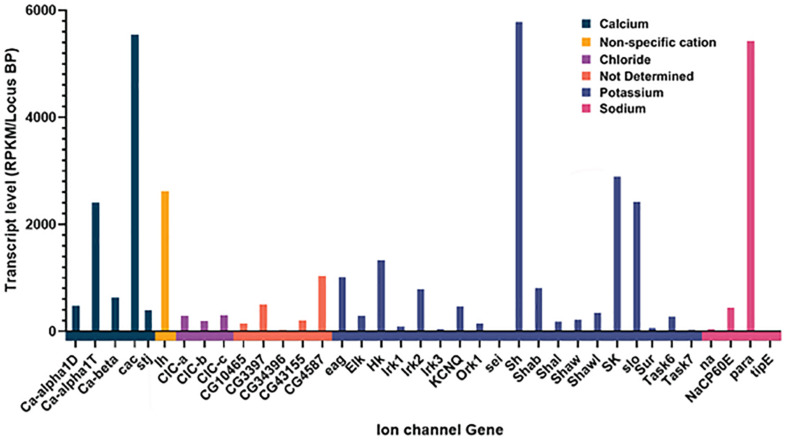
Expression of Ion channel genes in AKH cells through sc-RNAseq. Channels are grouped together by specificity and the normalized amount of transcript is plotted for each ion channel gene. Normalization was the total number of reads per kB mapped and normalized for transcript length.